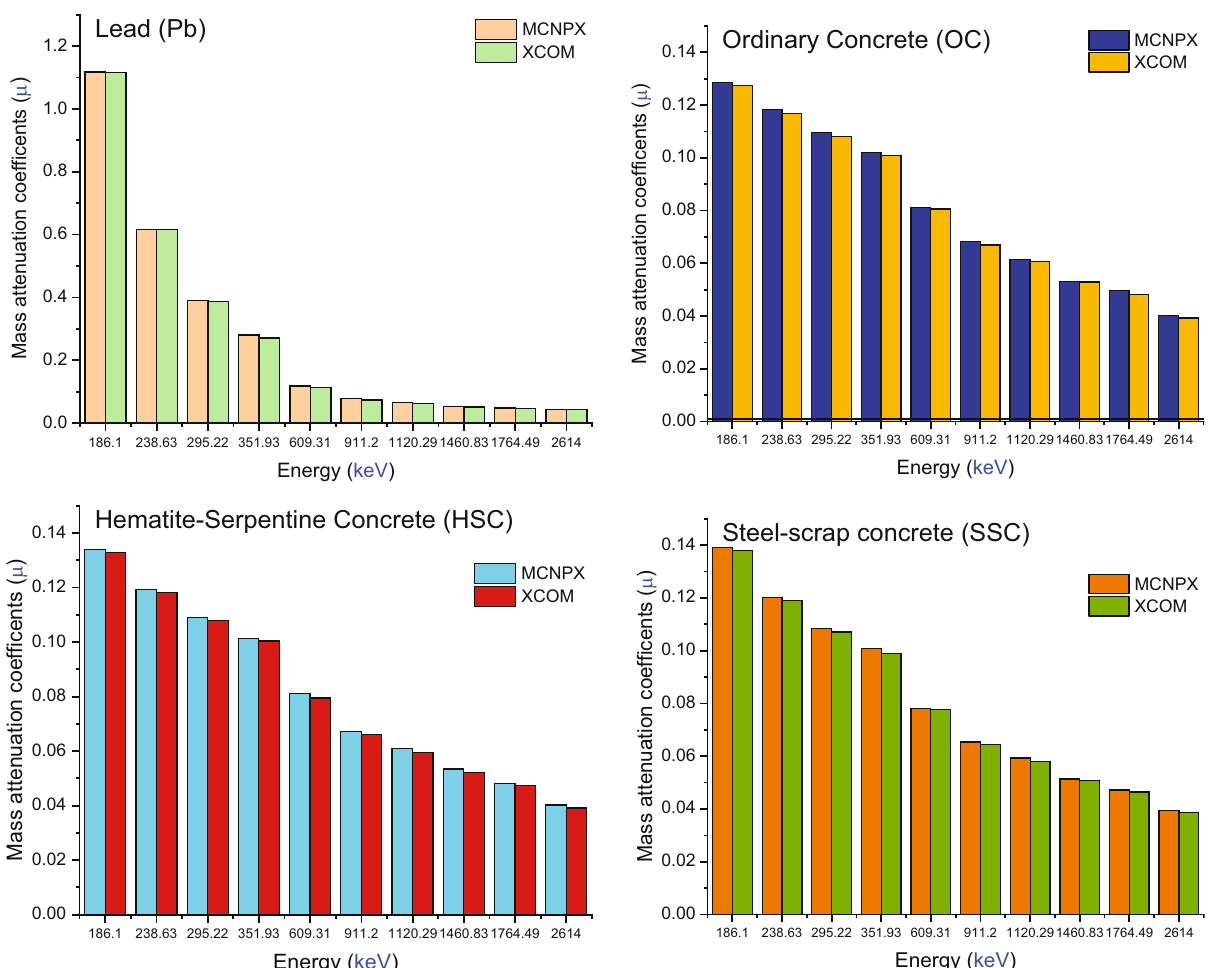
Figure 4: Comparison of mass attenuation coe ffi cients obtained from standard NIST data ( XCOM ) and modelled NaI ( Tl ) detector in MCNPX.